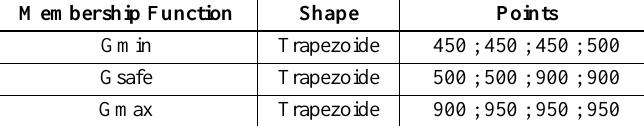
Table 6: Member functions of potentiometer G.